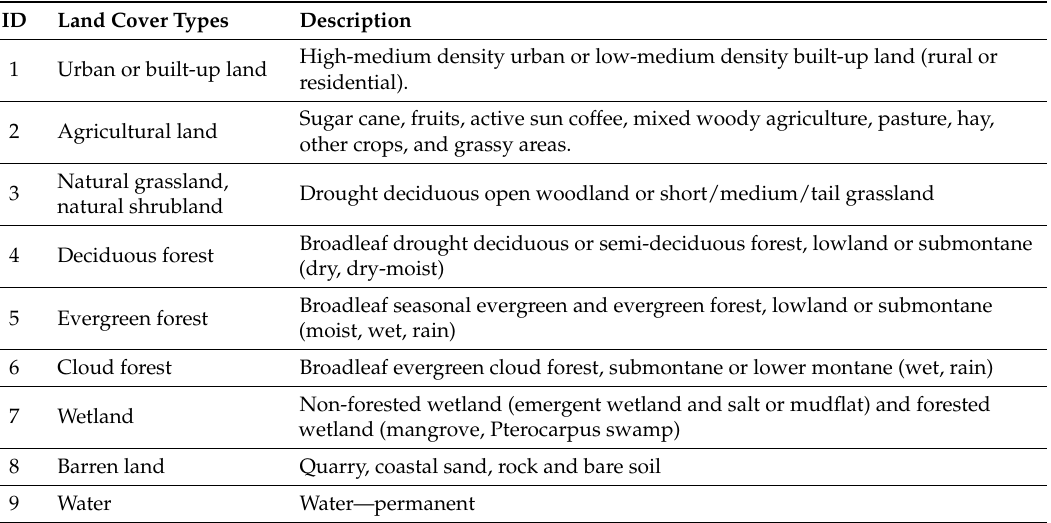
Table 3. Land cover types for the islands of Dominica and Puerto